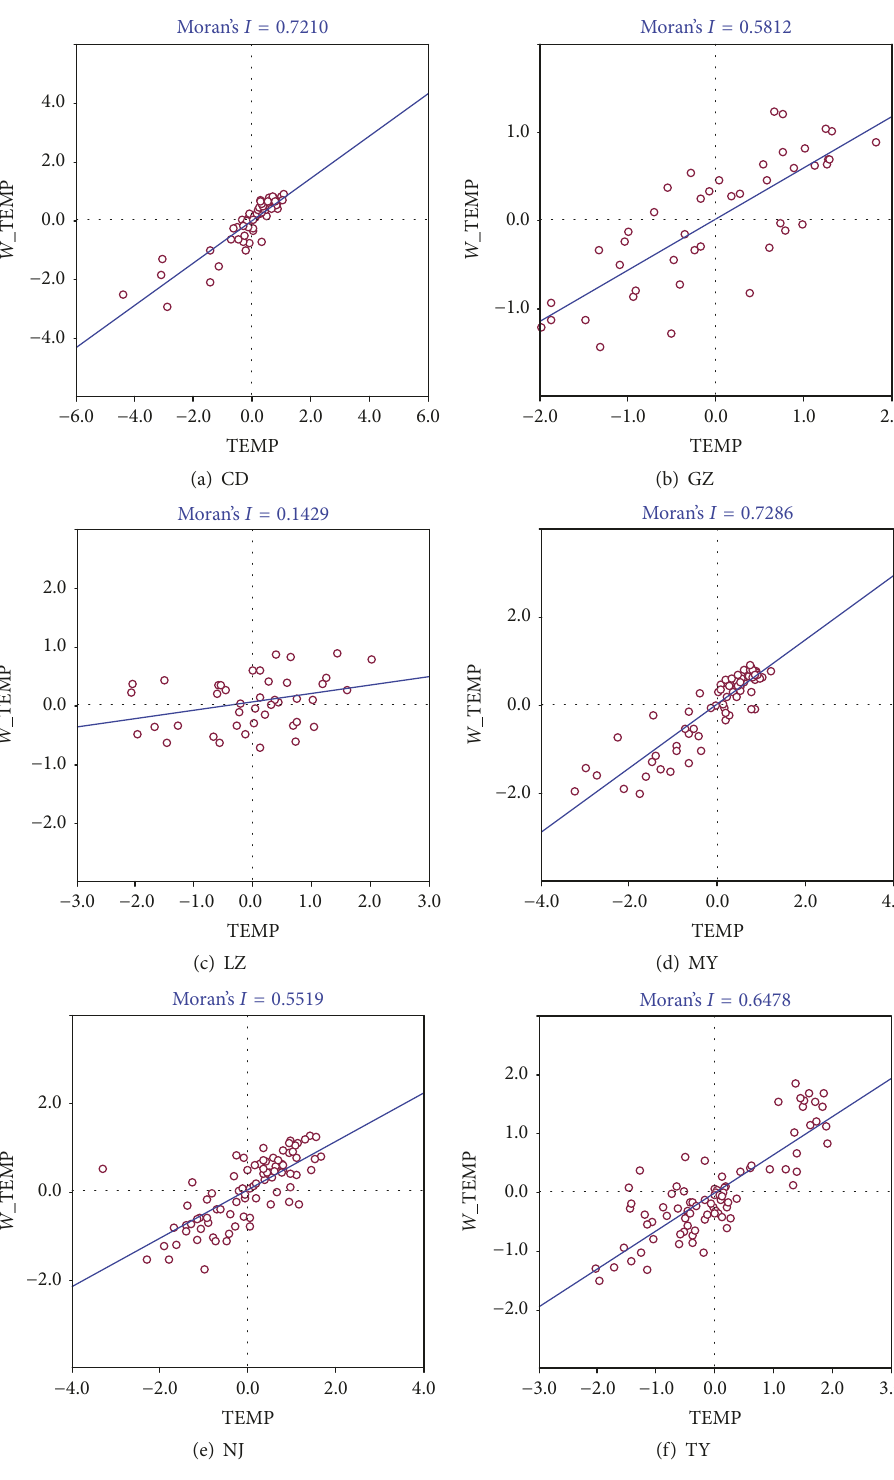
Figure 4: Moran’s 𝐼 values of six regions at some